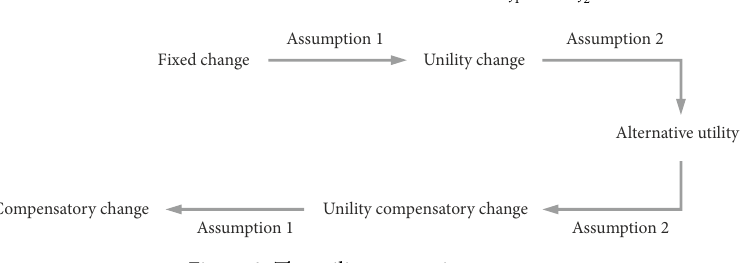
Figure 1. The linear utility functions of